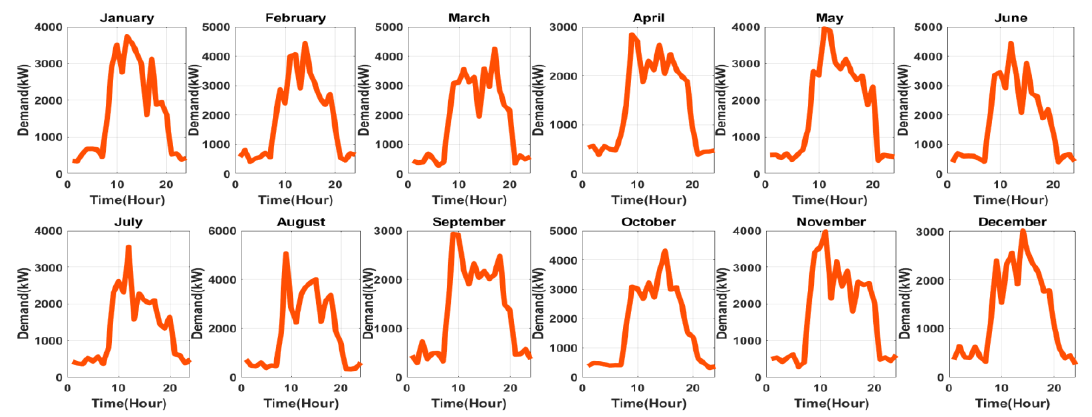
Figure 6. Thermal energy demand.